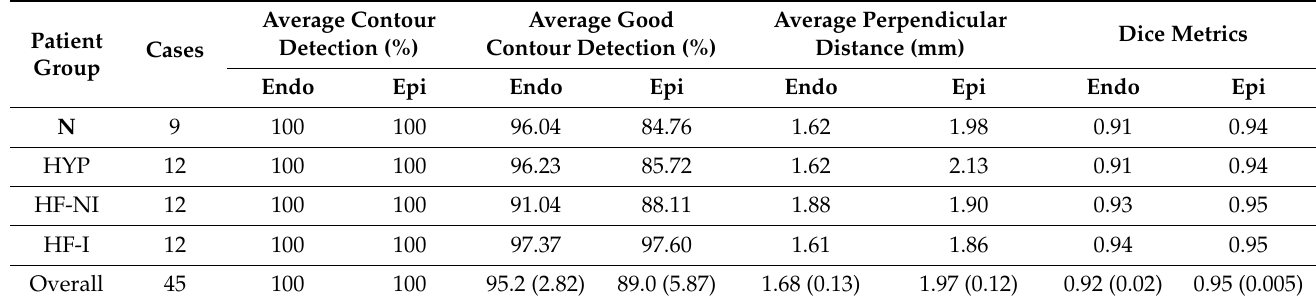
Table 10. Performance evaluation parameters for focal Tversky loss and Relu activation.